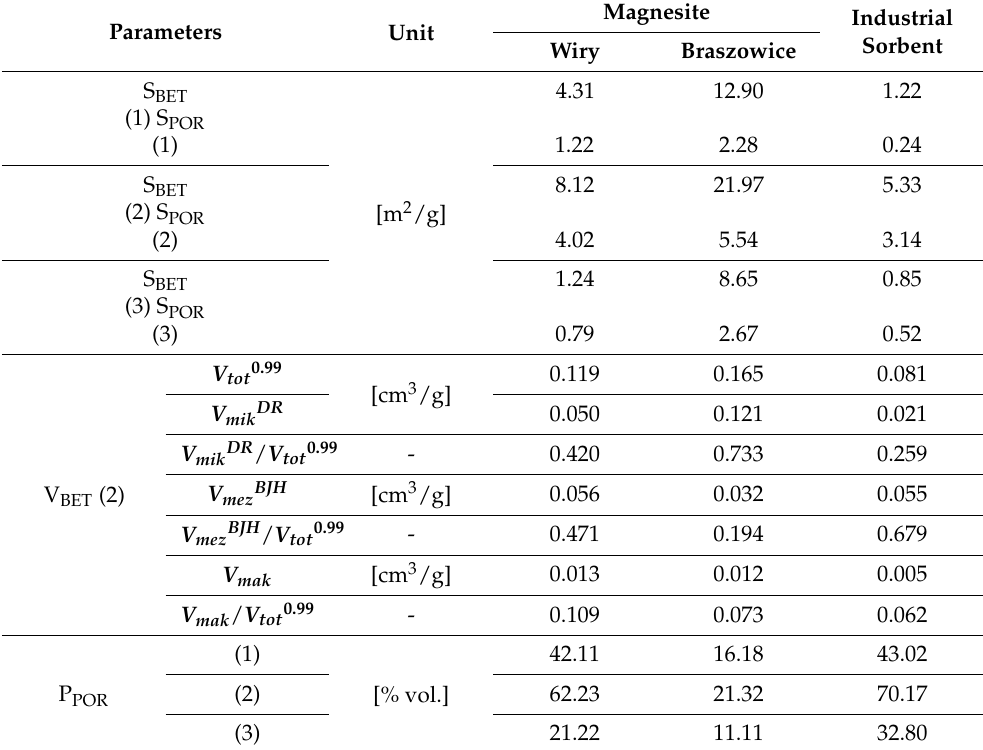
Table 7. The porous texture parameters determined by low-temperature nitrogen sorption of individ- ual lithological varieties of the magnesites form Wiry and Braszowice and industrial sorbent after the decarbonation process. Parameters Unit